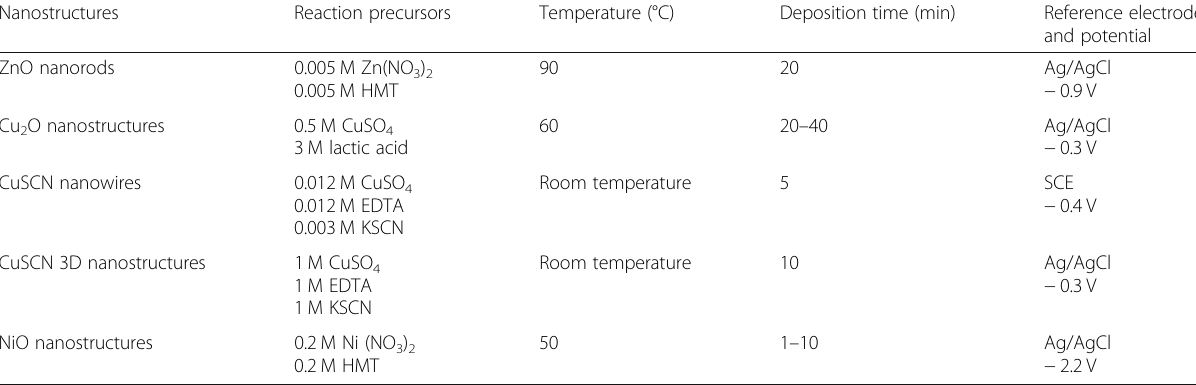
Table 1 Reaction conditions for the fabrication of the nanostructures by electrodeposition